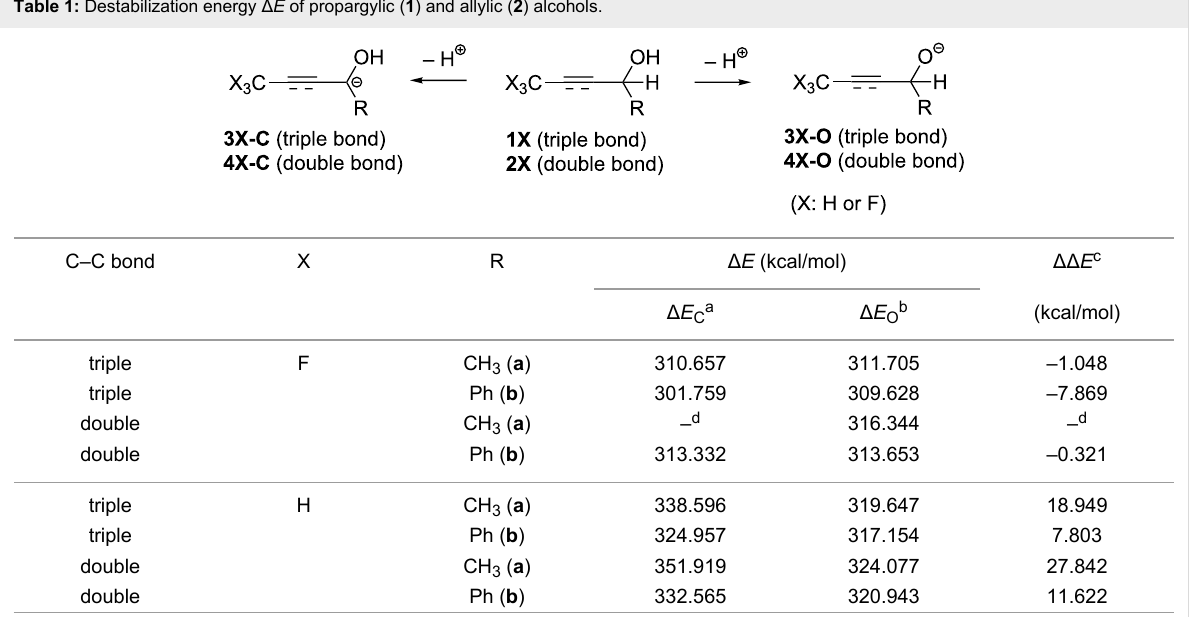
Table 1: Destabilization energy Δ E of propargylic ( 1 ) and allylic ( 2 )